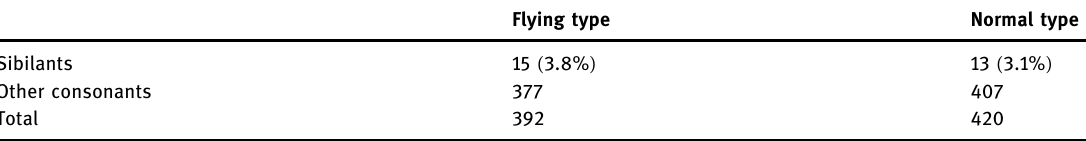
Table 2: The distributions of voiceless sibilants and other consonants in the names of the fl ying - type and normal - type characters in Japanese. The analysis is based on the data from Kawahara et al. ( 2018 ) , which includes all the characters up to